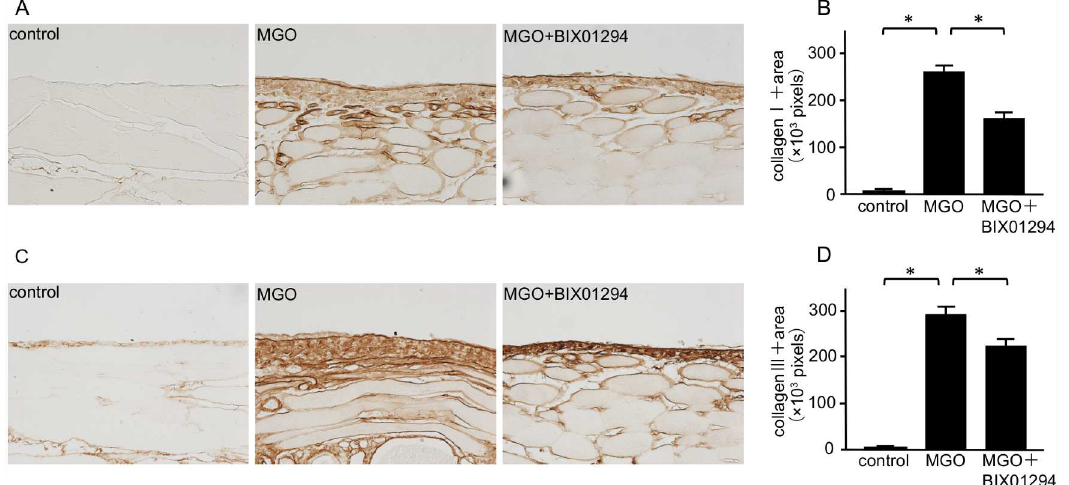
Fig 4. BIX01294reduces collagen I and III expressionin mice with peritoneal fibrosis. (A) Immunohistochemical staining shows typical collagenI expressionin peritonealtissue of control mice, MGO-injected mice, and MGO-injected mice treated with BIX01294(originalmagnification, × 200). (B) Graph indicatesthe number of collagenI-positive pixels in the three groupsof mice. (C) Immunohistochemicalstaining shows typical collagenIII expressionin the peritonealtissue of control mice, MGO-injected mice, and MGO-injected mice treated with BIX01294(originalmagnification, × 200). (D) Graph indicatesthe number of collagenIII-positive pixels in the three groups of mice. Data are expressedas the mean ± SE. Statistical analysiswas performed by analysisof variancefollowedby Tukey’s post-hoc test. * P < 0.05, n = 5 mice per